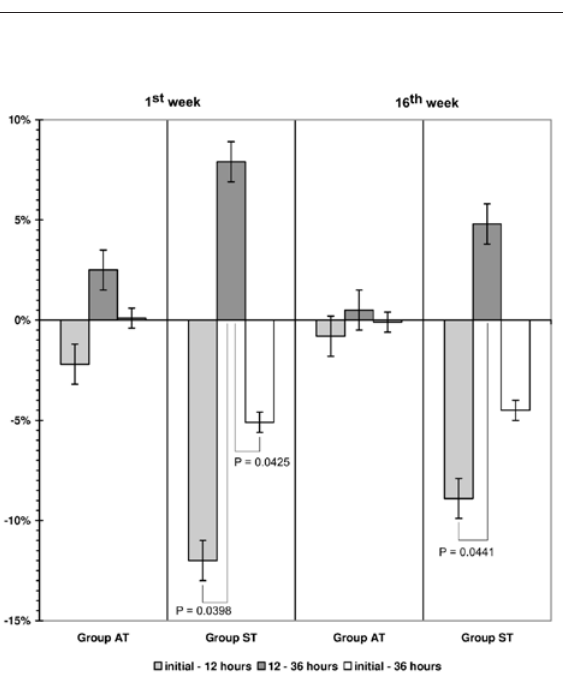
Figure 2: Post-exercise changes of resting respiratory exchange ratio (as % of initial basal level) at 12 and 36 hours after training session in groups of aerobic (AT) and strength (ST) training. Data for the 1st and the 16th week of training are